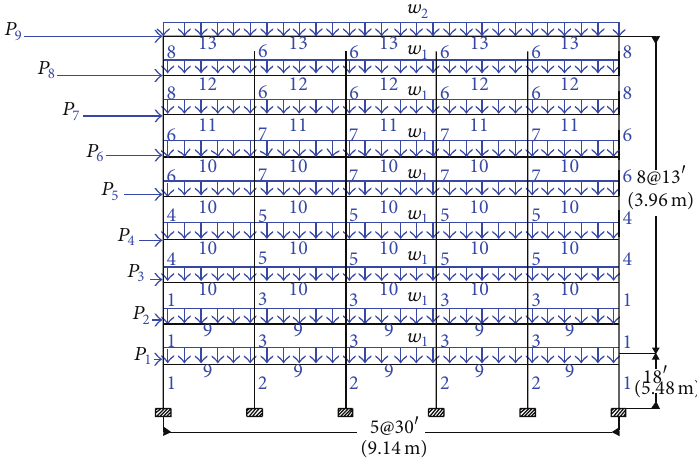
Figure 3: Nine-story steel moment frame. Table 2: The statistical information of performance-based optimum designs for the 4-bay 9-story frame.